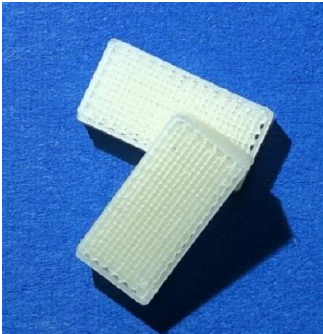
Figure 2. Picture of printed objects (3 × 15 × 7.5 mm) using in-house-produced filaments based on EC and HPMC for the evaluation of uniformity of mass according to Ph.Eur. 2.9.5.